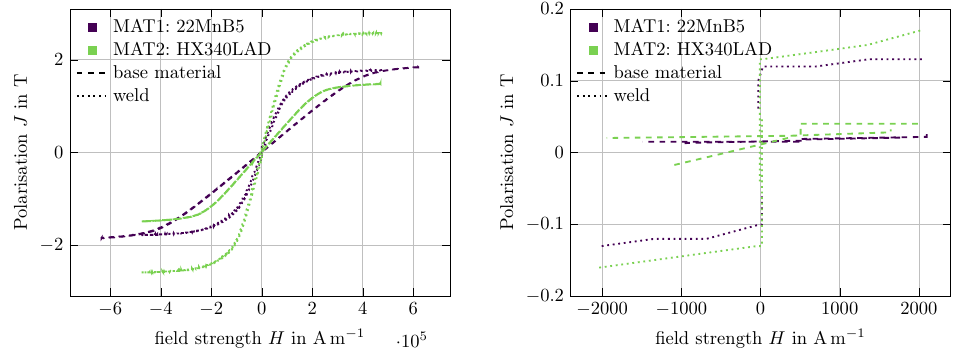
Figure 9. Measurement results of VSM-measurements of the base material and the weld of MAT1 and MAT2 in full scale ( left ) and in detail ( right